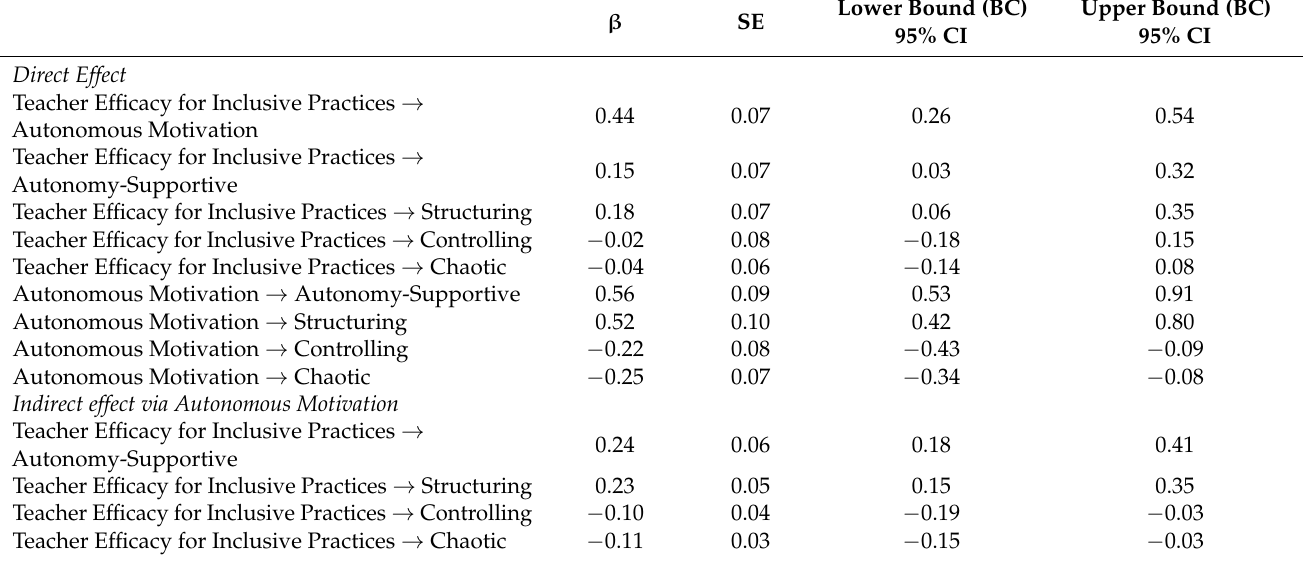
Table 2. Path estimates, SEs and 95% CIs.